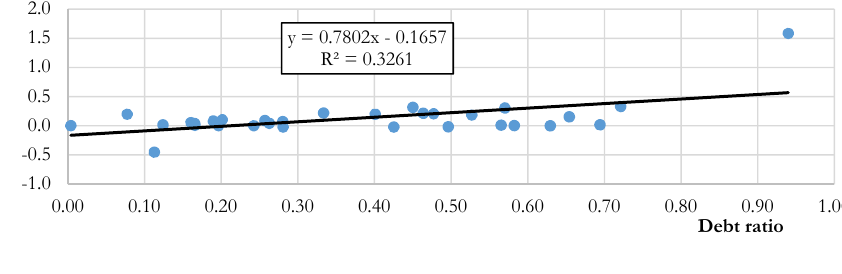
Fig. 4 – Relationship of ROE and debt ratio in the business sector B - Mining and quarrying. Source: Own